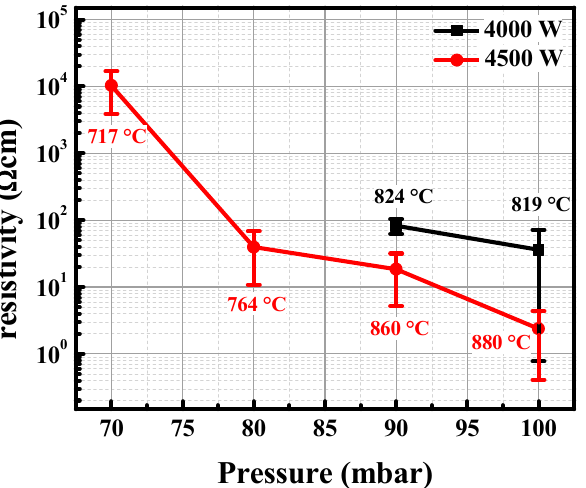
Figure 5. Electrical measurements for N-UNCD films grown at different total pressures at 4000 and 4500 W.